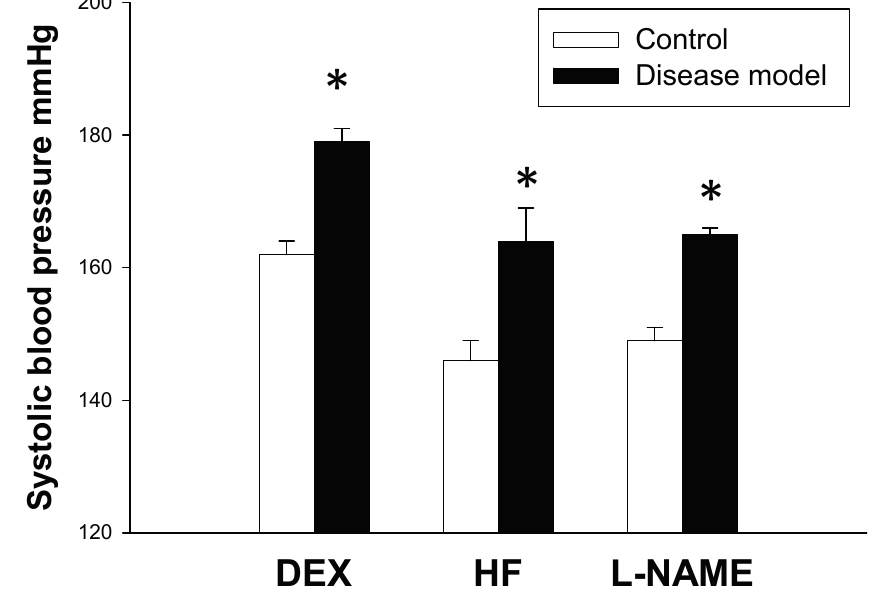
Figure 1. Effects of dexamethasone (DEX), high-fructose intake (HF), and N G -nitro- L -arginine-methyester ( L -NAME) on systolic blood pressure in male adult offspring. n = 6 per group. * p < 0.05 vs.